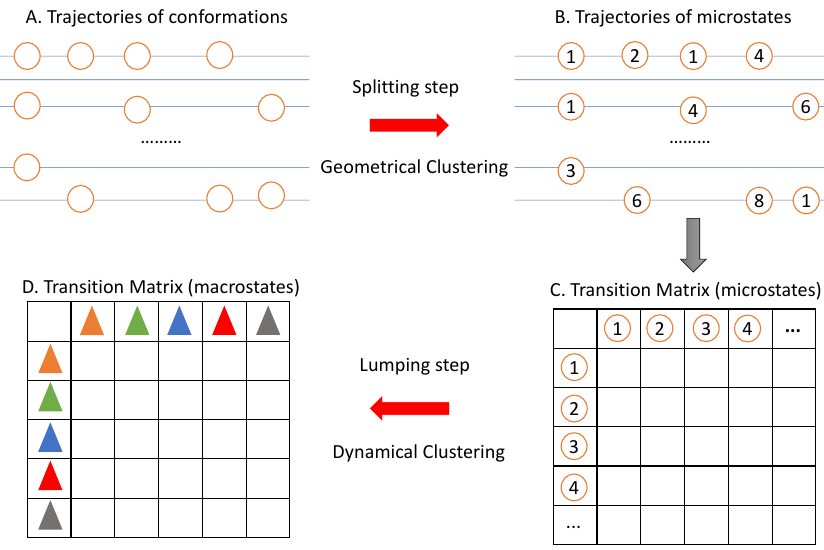
Figure 2. Workflow of the two-step clustering framework for learning metastable states. ( A ) Trajecto- ries of conformations obtained from MD simulations. Each circle represents a different conformation. ( B ) Trajectories of microstates resulted from the splitting step. This step uses only the geometrical information to cluster conformations with high geometrical similarity into a microstate. Circles of the same number represent the conformations belonging to a same microstate. ( C ) The transition matrix between microstates, which counts the number of jumps between them along the trajectories. ( D ) Transition matrix between macrostates obtained from the lumping step by clustering microstates into macrostates. Each macrostate is a collection of microstates. Solid triangles with different colors represent different